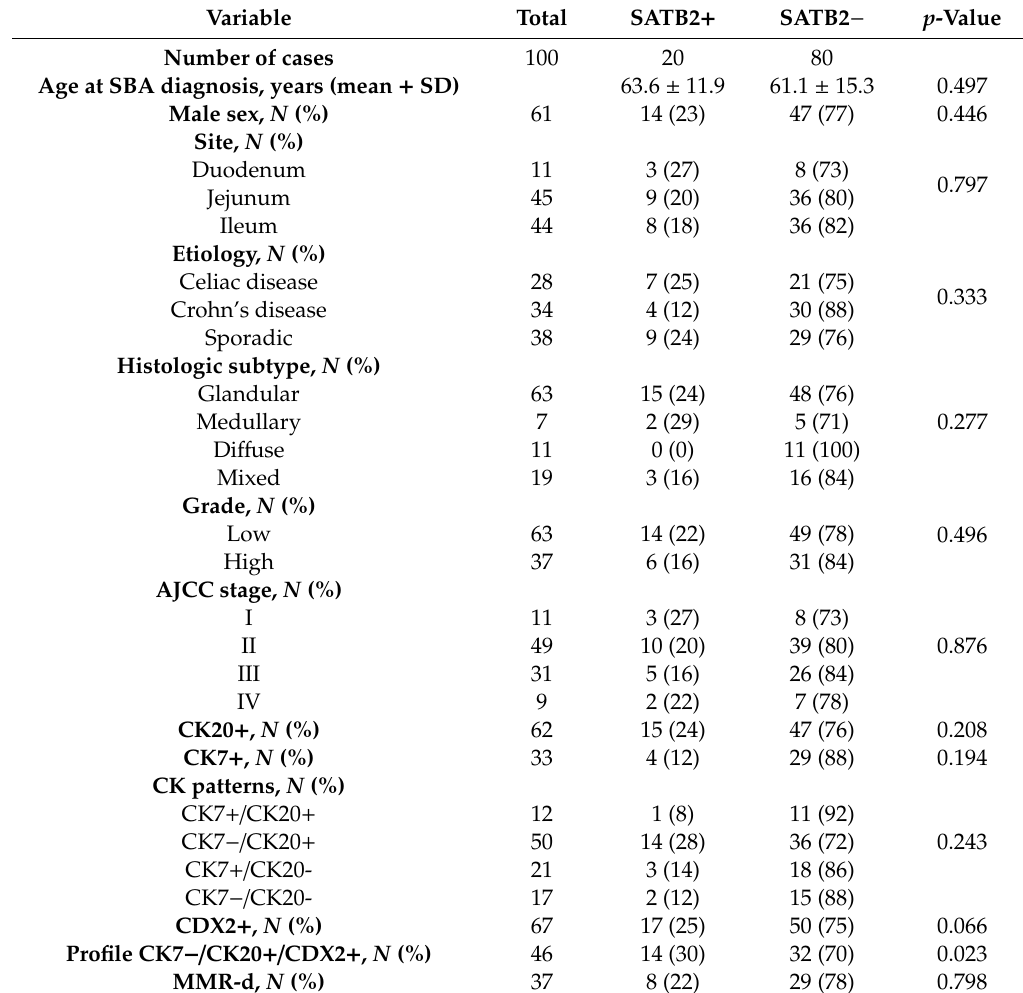
Table 1. Demographic and clinico-pathologic features of small bowel adenocarcinoma patients by SATB2 expression. Variable Total SATB2 + SATB2 − p -Value Number of cases 100 Age at SBA diagnosis, years (mean +